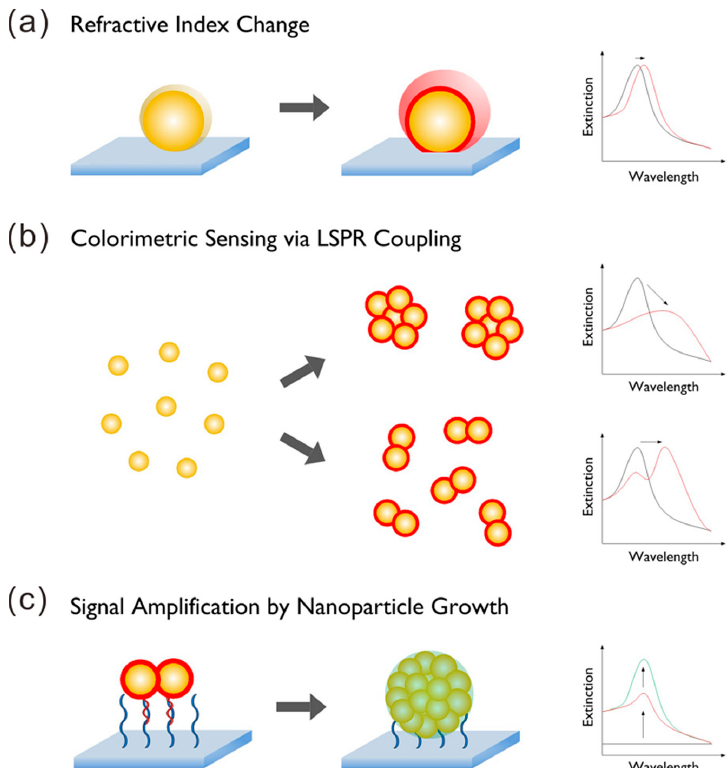
Figure 5. Illustration of different strategies to improve the sensitivity of plasmonic nanosensors. There are several types of methods that are available to influence the local dielectric properties surrounding plasmonic NPs that are motivated by factors such as ( a ) NP characteristics, ( b ) plasmonic coupling, and ( c ) amplification schemes. Three spectral graphs on the right of the figure give a sign for the change of the extinction spectra with the NP state. Adapted from [39], with permission from © 2015 Elsevier.